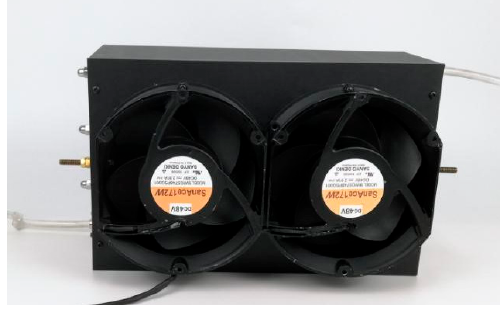
Figure 3. The 2 kW OC-PEMFC